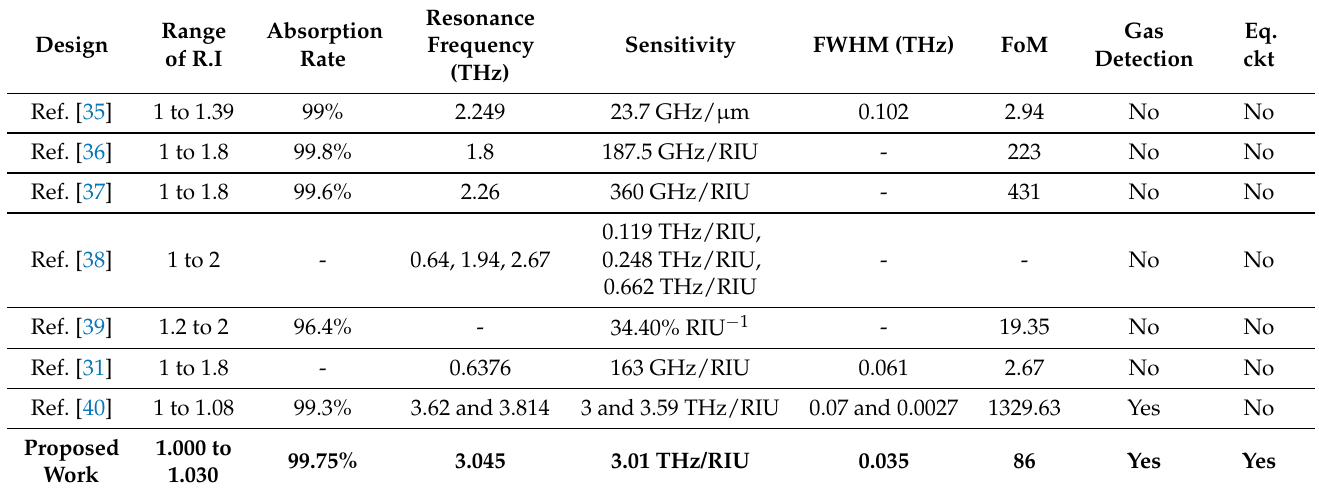
Table 2. Comparison of the proposed structure with those reported in the